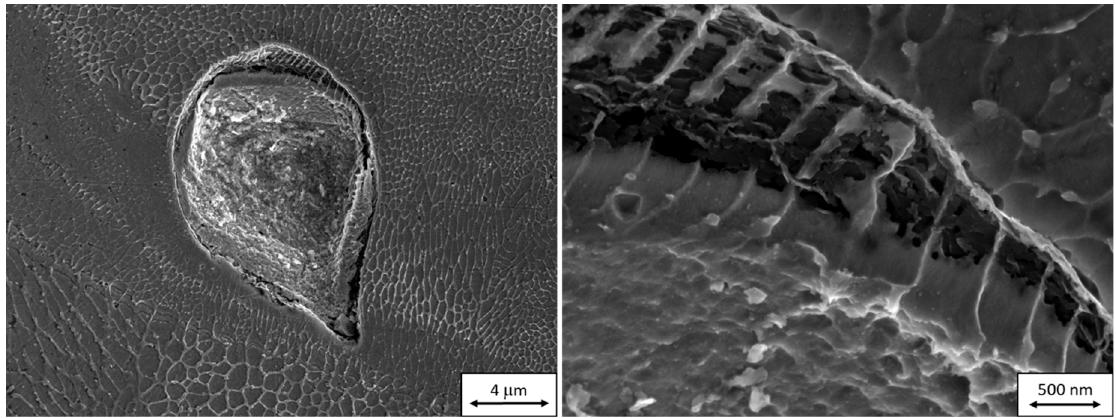
Figure 14. Defect in as-built material, possibly caused by a particle that failed to melt during